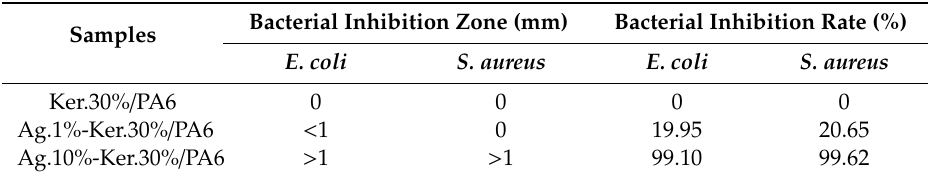
Figure S1: SEM images of coarse wool and commercial wool, Figure S2: Schematic diagram of SDS-PAGE gel electrophoresis, Figure S3: Pore size distribution of the composite membrane, Figure S4: Schematic diagram of filter e ffi ciency and pressure drop. Table S1: Pore size diameter, WVT, and QF of nano-structure mats, Table S2: Mass of residues, peak degradation temperatures and melting temperatures of the di ff erent nanofibers mats, Table S3: The peak melting temperature of the composite